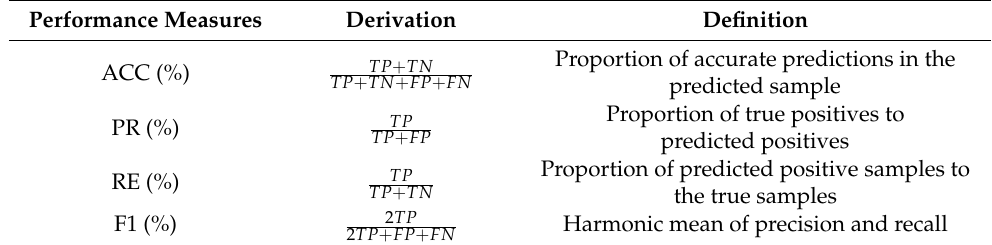
Table 4. Derivations and definitions of four performance